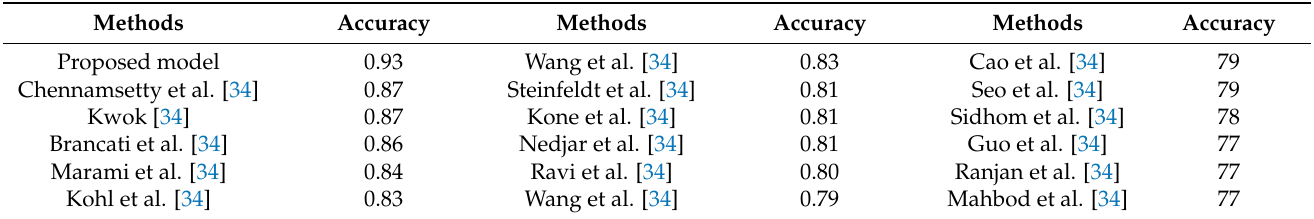
Table 6. Comparison of classification performance with ICIAR-2018 state-of-the-art on hidden test data (normalized by SA-GAN